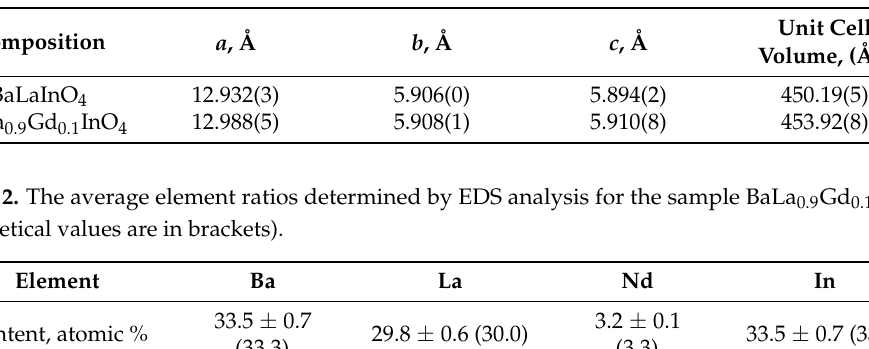
Table 1. The parameters of unit cell for compositions BaLaInO 4 and BaLa 0.9 Gd 0.1 InO 4 .